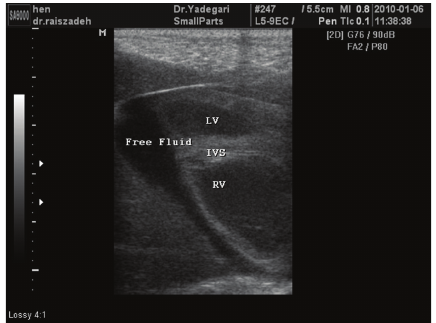
Figure 3: Pericardial effusion in group